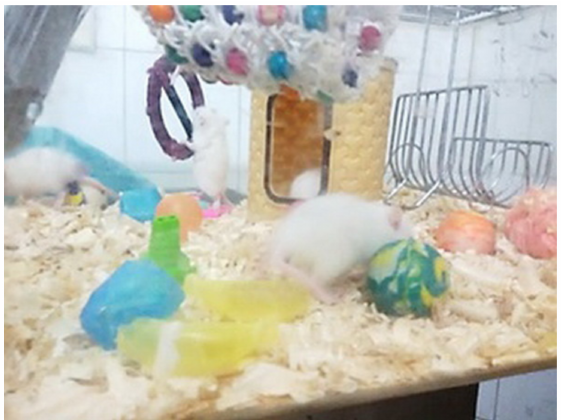
Figure 10. Example of environmental enrichment: after weaning at PND21, rats were kept in large cages with a greater number of rats, different objects and playing equipment which were changed every 5 days, until the behavioral test